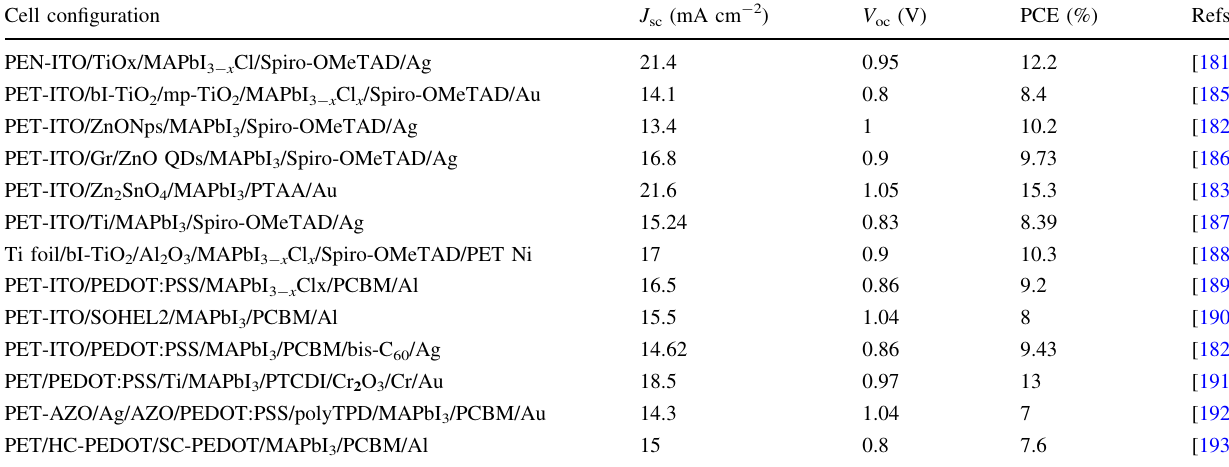
Table 7 Photovoltaic performance of some recent flexible perovskite solar cells Cell